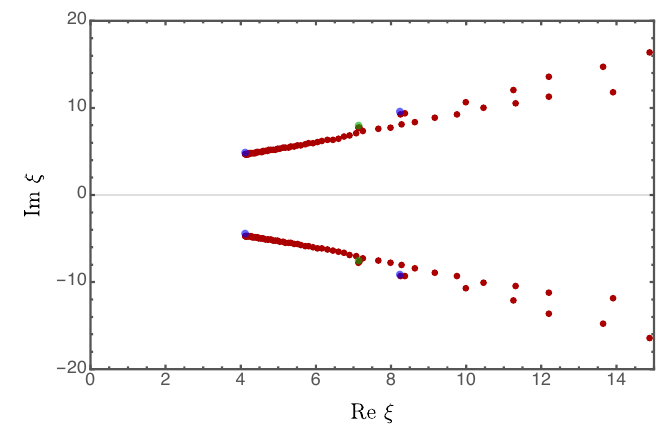
plane. In addition in colour: −